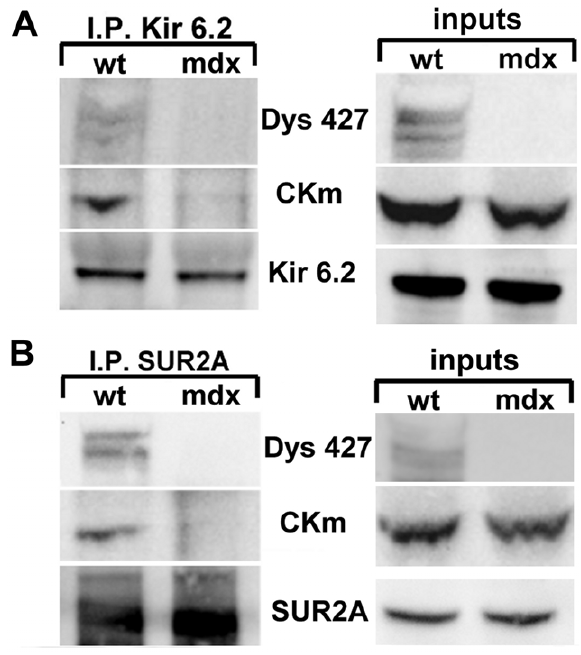
Figure 7. CKm and Dys427 are immunoprecipitated by Kir6.2 and SUR2A. Lysates from wt and mdx mouse hearts were immunoprecipitated with an anti Kir6.2 (A) or SUR2A (B) antibody. Blots were probed with anti CKm, Dys427, Kir6.2 and SUR2A antibodies. Inputs (right panels) show that CKm is present in both wt and mdx lysates but is co-immunoprecipitated by Kir6.2 or SUR2A only in wt lysates where Dys427 is present.